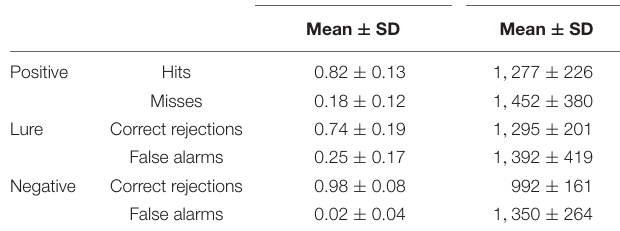
TABLE 1 | The proportion of responses and reaction times for response types in both